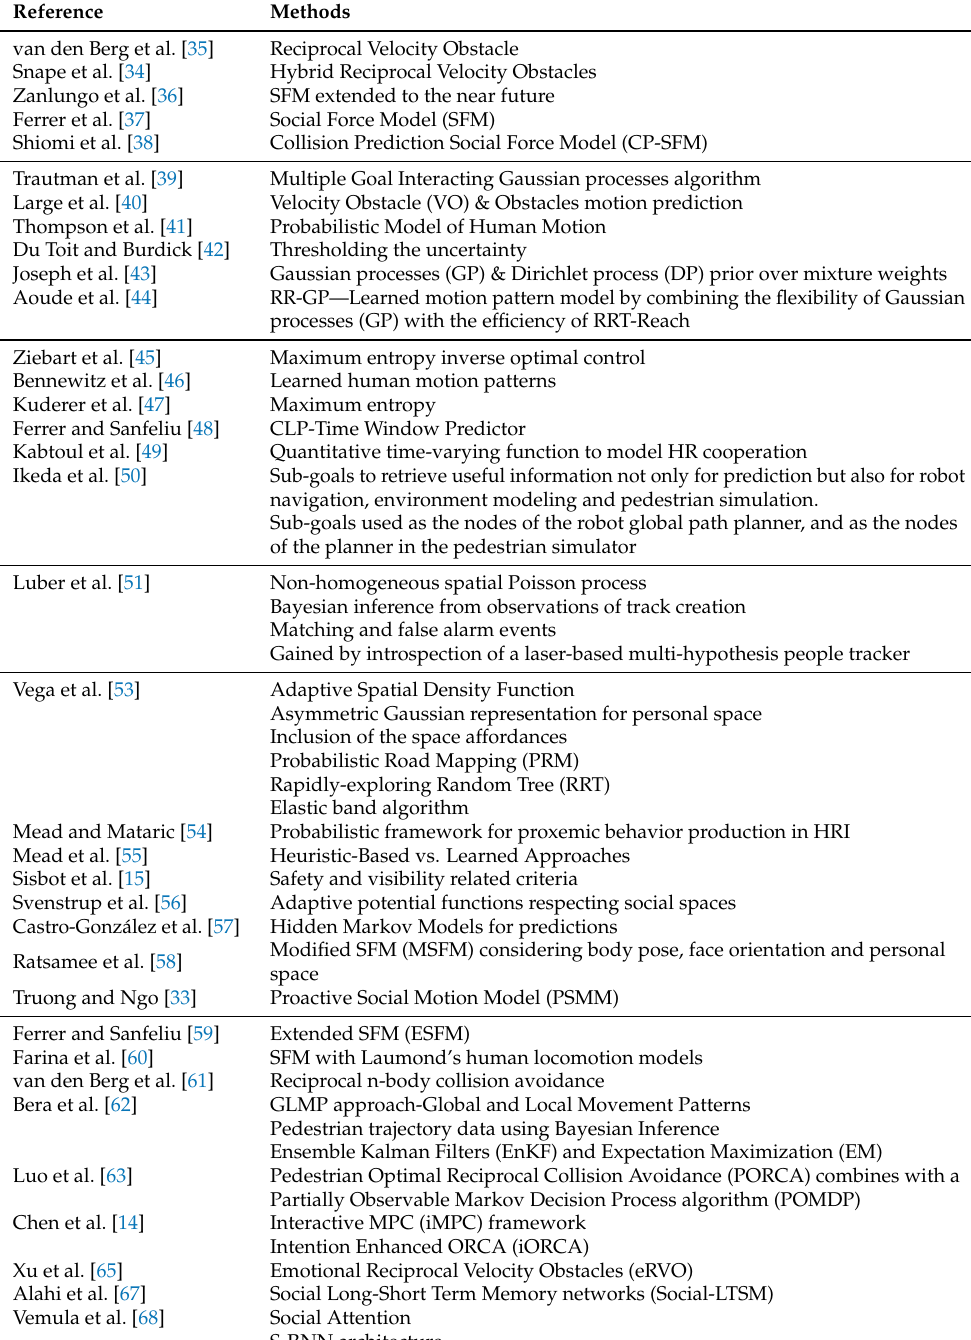
Table 2. Approaches considered in Section 3.2.1. The table covers the methods they use for modeling human